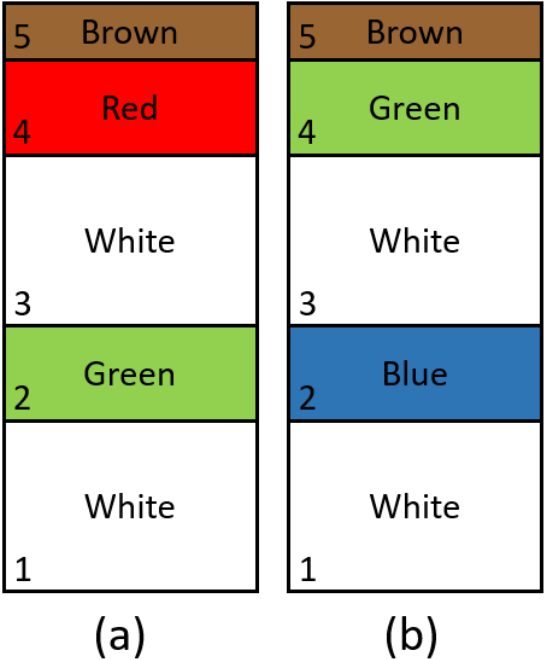
Figure 2. Scheme of the layer sequence in painting materials in the wig ( a ) and in the body ( b ) of the sculpture. The thickness of the layers is not in sculpture. The thickness of the layers is not in scale.